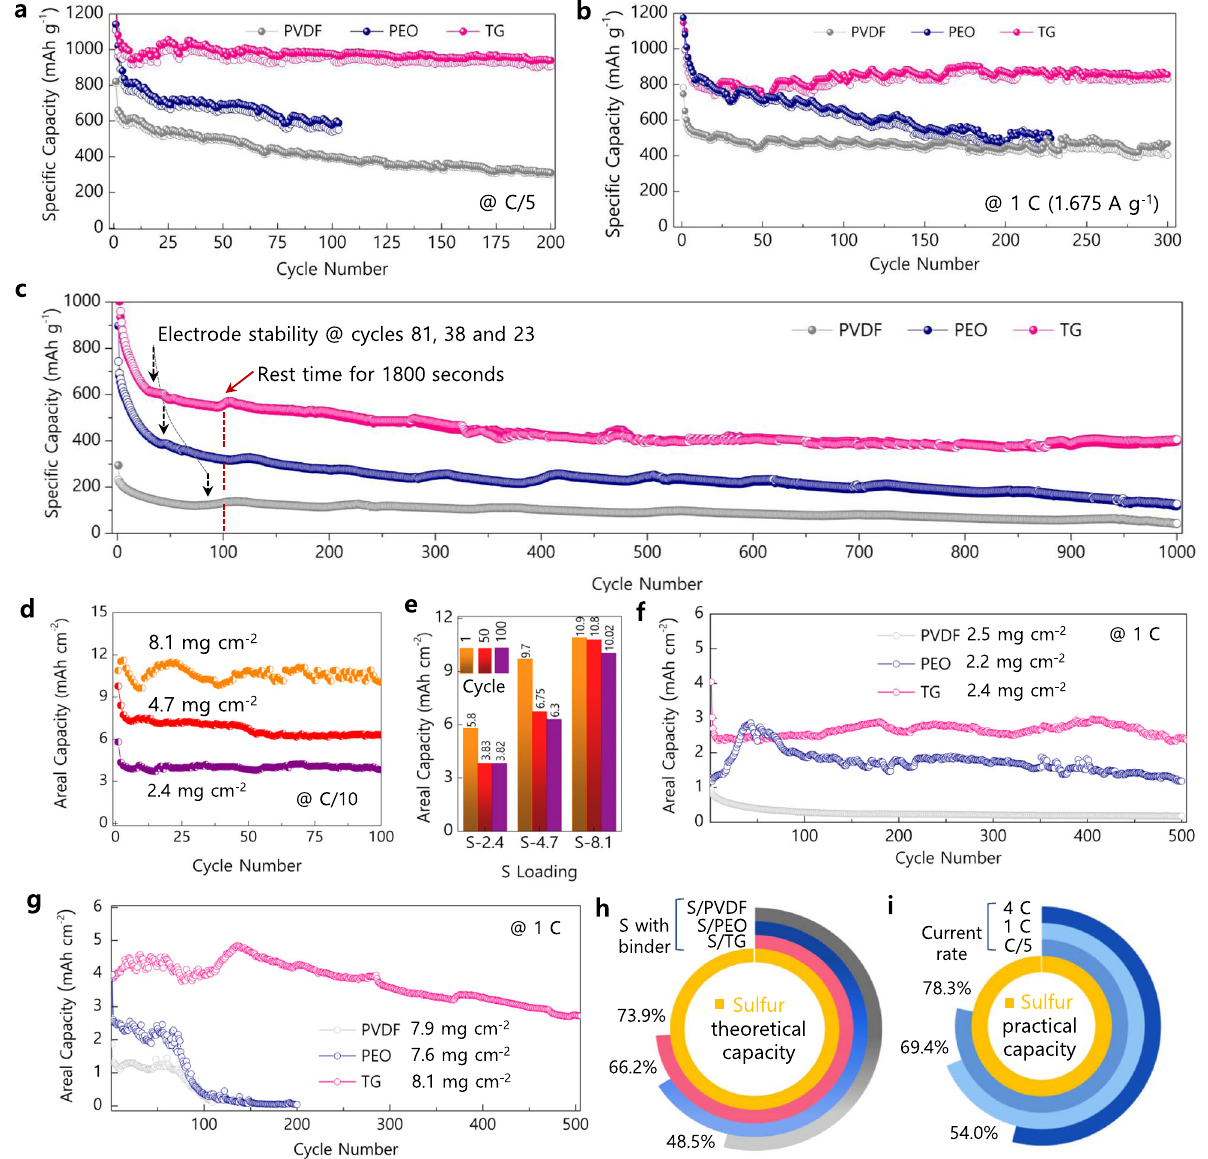
Fig. 3 Capacity retention and sulfur utilization analysis of sulfur cathodes with PVDF, PEO, and TG binder. a – c Cycling performances obtained at current rates C/5, 1 C, and 4 C, respectively. d , e Cycling performance with various sulfur loading using TG binder. f , g Long-term cycling stability for high sulfur-loaded S/PVDF, S/PEO, and S/TG electrodes at a current rate of 1 C. h Sulfur utilization for various binders at C/5 (against a theoretical capacity of S = 1675 mAh g – 1 ). i Sulfur utilization for S/TG electrodes at various current rates of 4 C, 1 C, and C/5 (against a practical capacity of